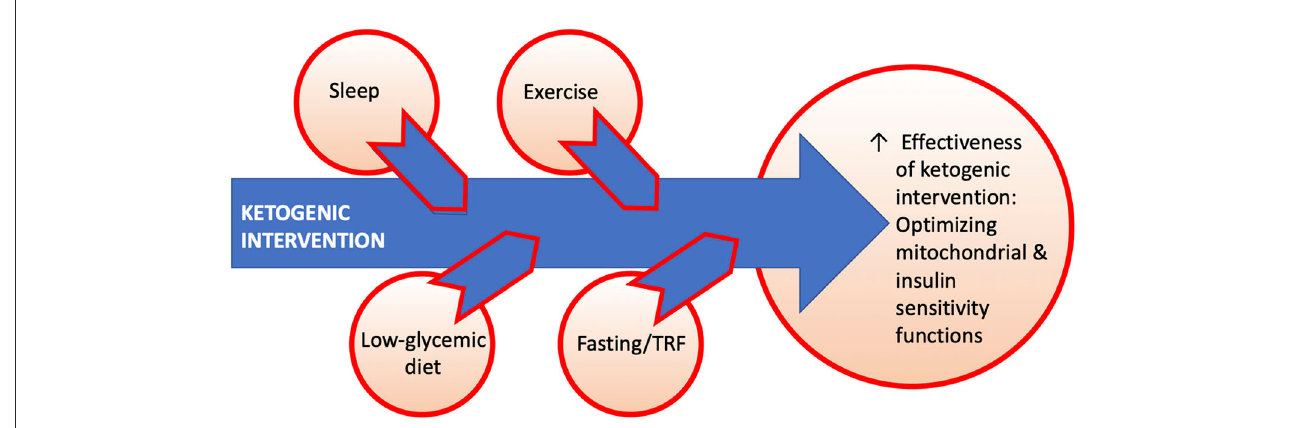
FIGURE3 Hypothesized conceptual model of actionable sleep, exercise, diet, and fasting/time-restricted feeding (TRF) lifestyle factors that may augment effects of ketogenic